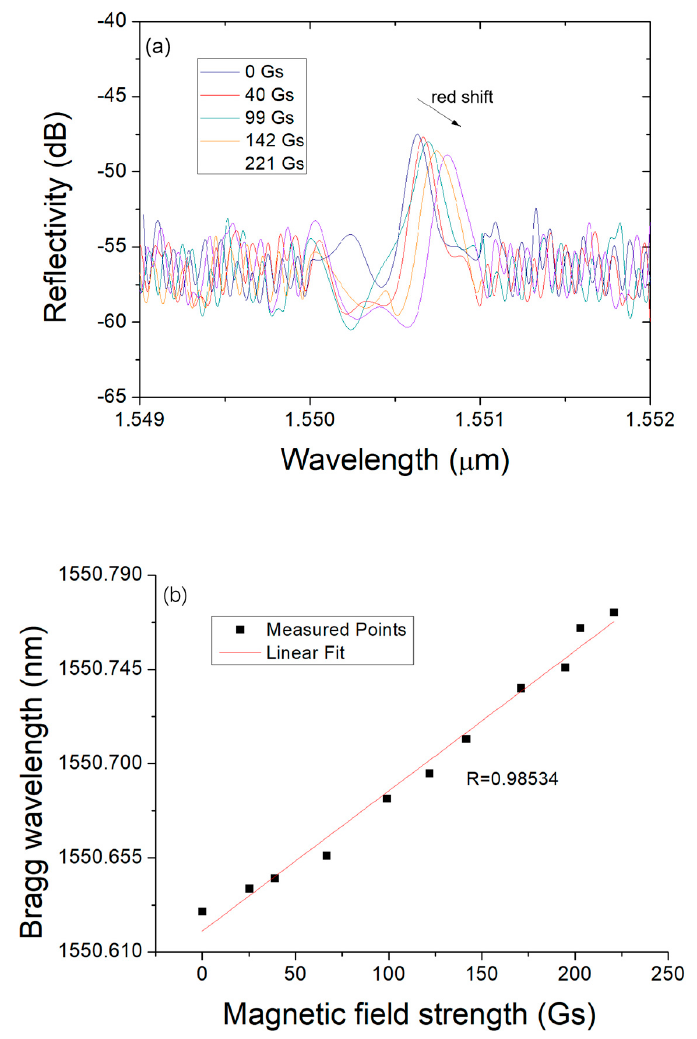
Figure 7. ( a ) Reflected spectra versus different magnetic field intensity. ( b ) Relation between the Bragg wavelength and the magnetic field strength.